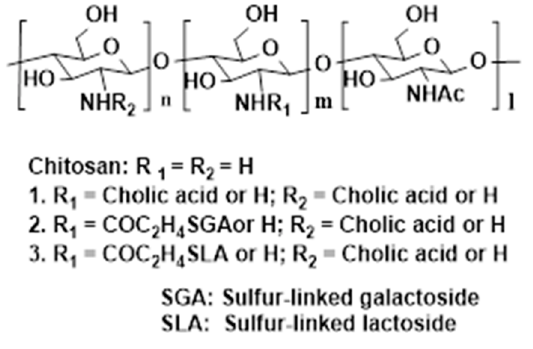
Figure 1. The structures of designed compounds 1 , 2 and 3 .